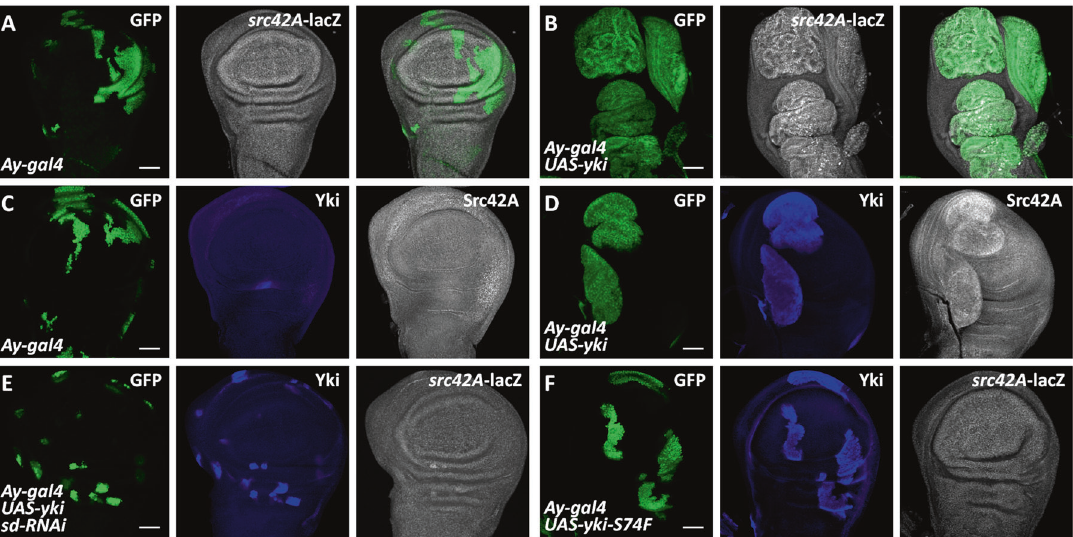
Fig. 2 Yki activates src42A transcription. A A control wing disc expressing GFP via Ay-gal4 was stained to show GFP (green), Yki (blue) and src42A -lacZ (white). Notably, src42A -lacZ evenly expresses in the wing disc. B Overexpression of yki apparently promoted src42A -lacZ expression. C A control wing disc was stained with GFP (green), Yki (blue), and Src42A (white). D Ectopic expression of yki by Ay-gal4 increased Src42A protein level. E A wing disc simultaneously expressing yki and sd RNAi was stained to show GFP (green), Yki (blue) and src42A -lacZ (white). Knockdown of sd effectively suppressed Yki-induced src42A -lacZ upregulation. F Yki-S74F failed to activate src42A -lacZ expression in the wing disc. Scale bars: 50 μ m for all